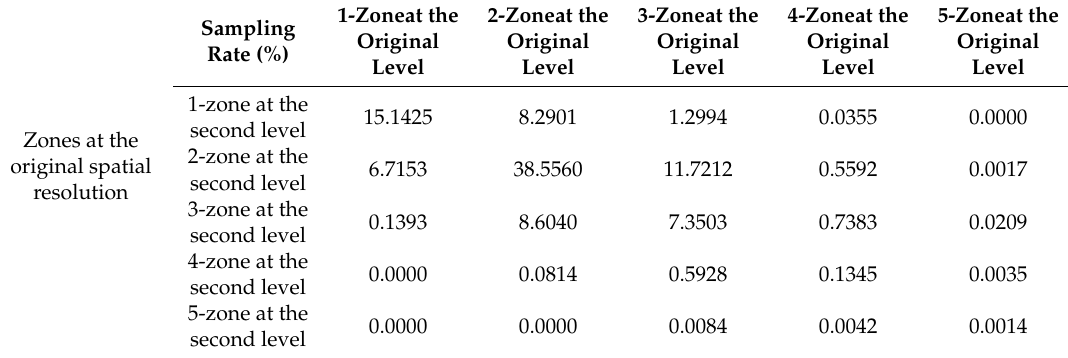
Table 5. Sampling rate of each zone at the original spatial resolution